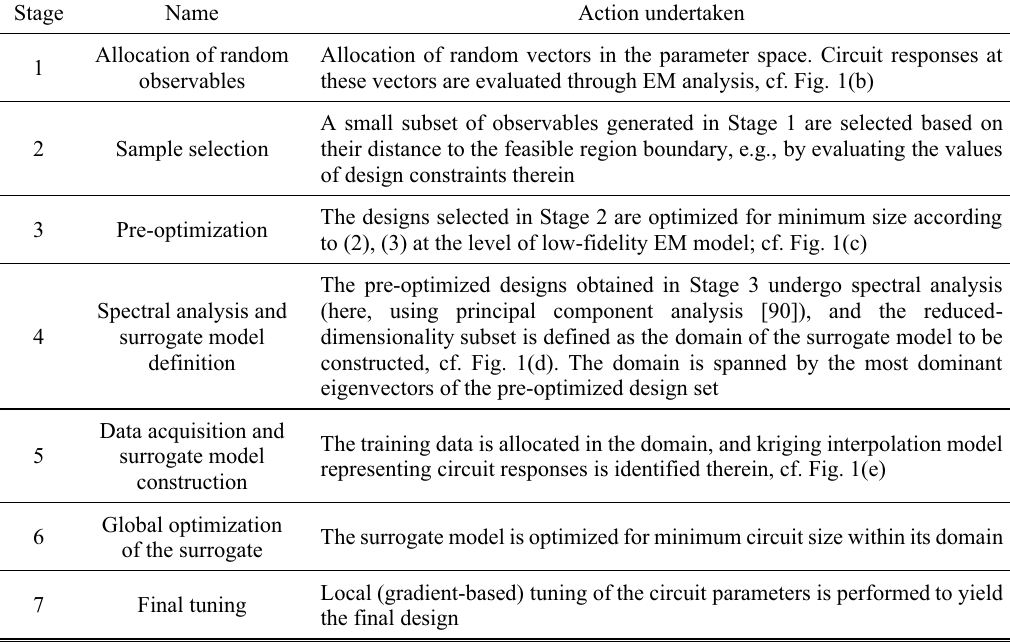
Figure 2. Conceptual stages of globalized size reduction of microwave